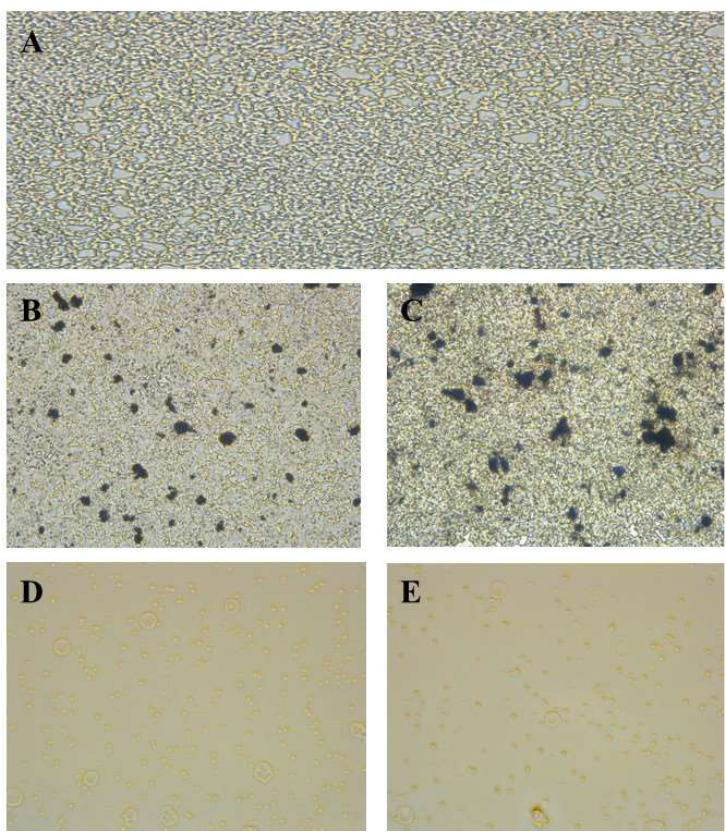
Figure 7. Results observed under an inverted microscope (40 × ) ( A ). MRSA biofilm